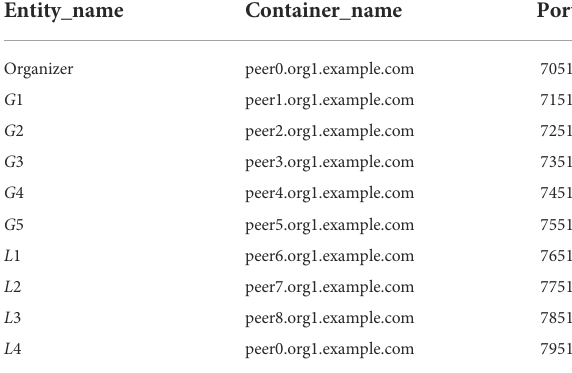
TABLE 1 Con fi guration of each node